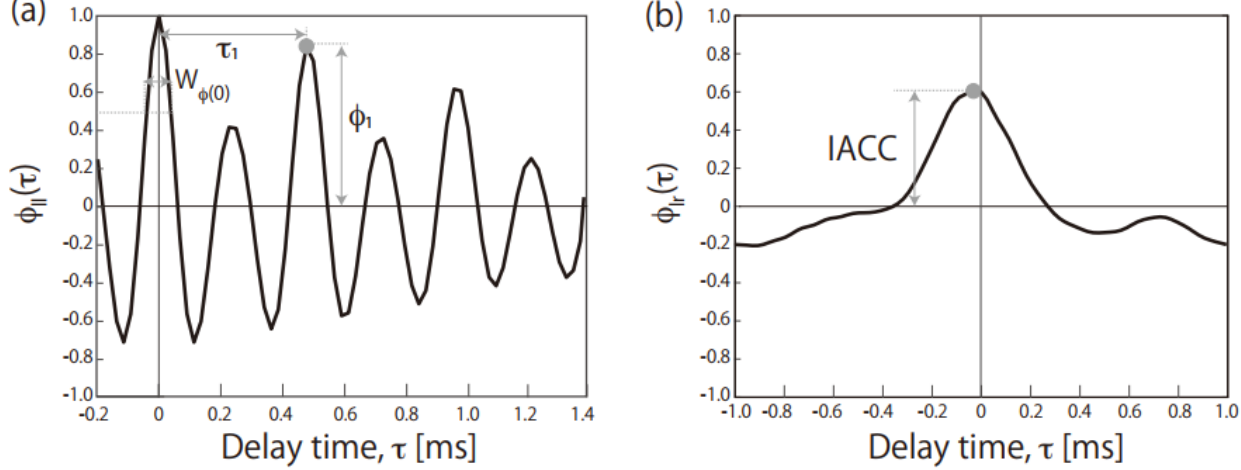
Figure 1. ( a ) Normalized ACF of Cicada as a nature-generated sound and ( b ) normalized IACF of